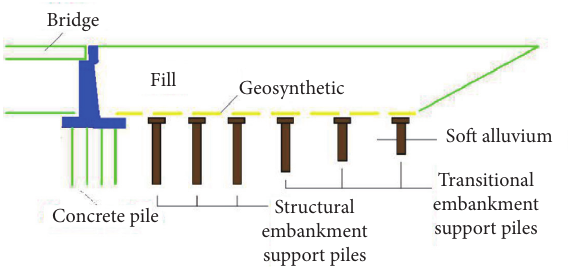
Figure 1: Sketch of the GRPS embankment used at bridge approach.